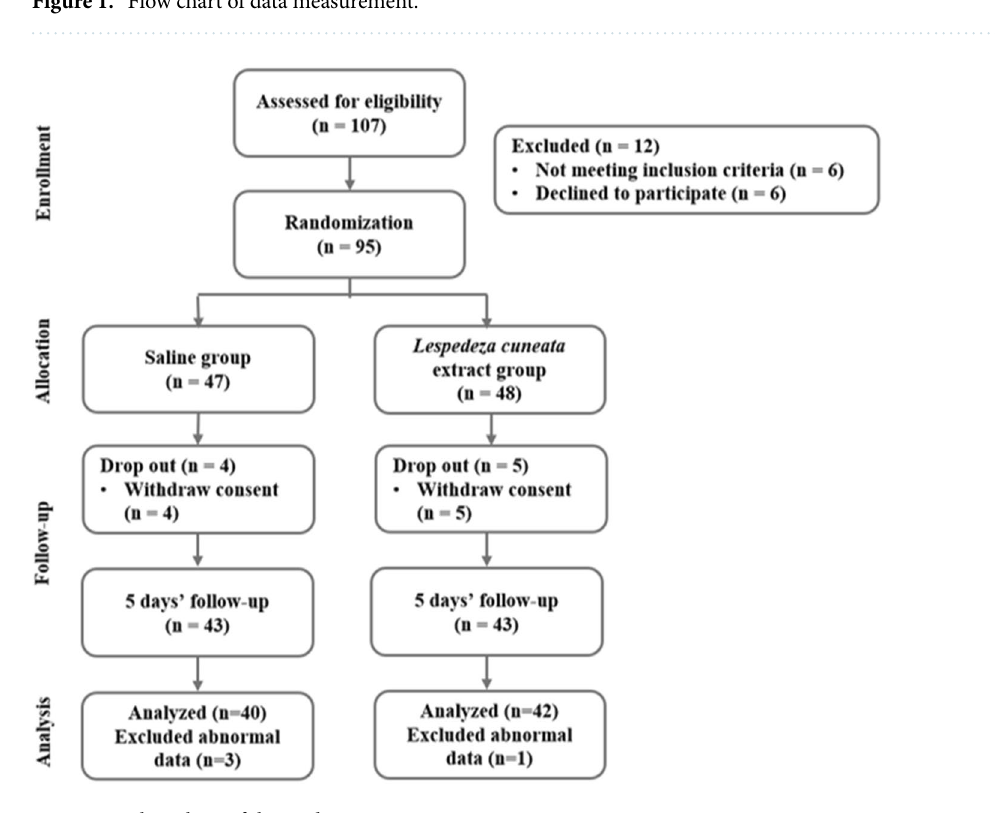
Figure 2. Flow chart of the